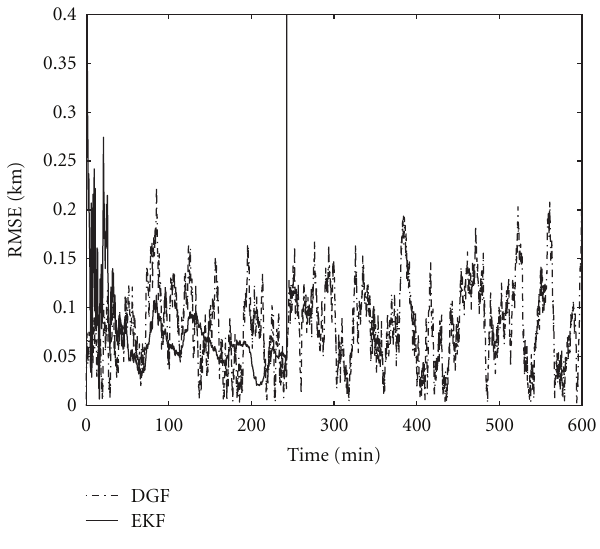
Figure 10: RMSE comparison (Unstable